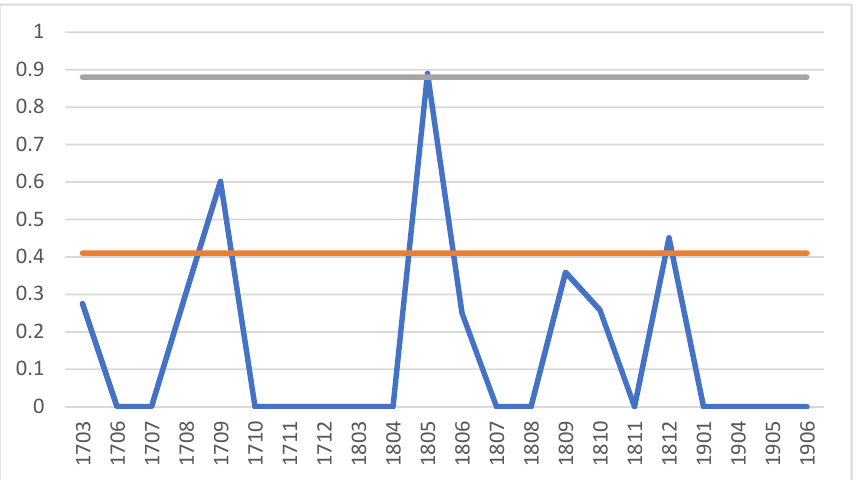
Figure 7. Keyword frequency of the antecedent “management”. Figure 8 represents the keyword frequency of the antecedent “service provider”. The gray line represents the upper cut-off value, and the orange line represents the lower cut-off value. It indicates that the keyword “service provider” belonged to the upper range (1.02–2.13) in April and May 2018. Mathematics 2020 , 8 , x FOR PEER REVIEW